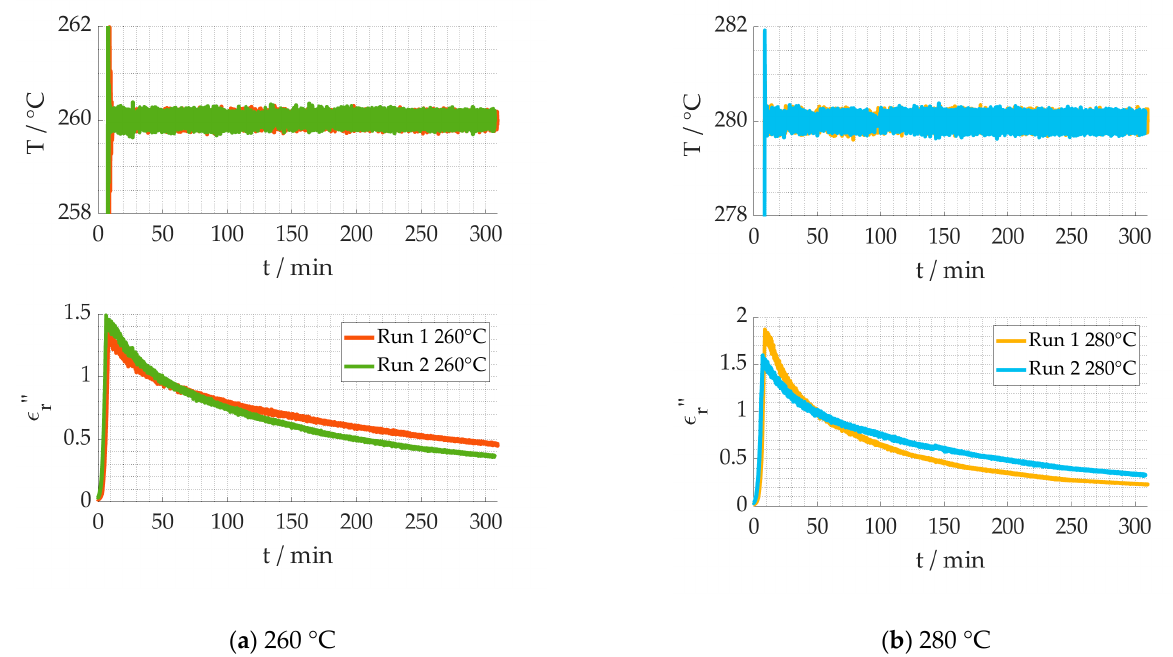
Figure 10. Dielectric loss of the same process parameters measured at different campaigns.